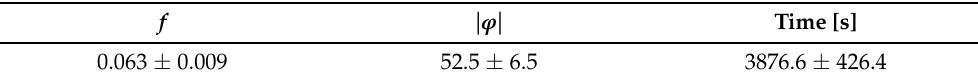
Figure 6. Median ± standard deviation (across the 10 evolutionary runs) over the evolution. Table 1. Fitness f , solution (derivation tree) size | ϕ | for the best individuals found in each run, and evolution time in seconds. Reported as median ± standard